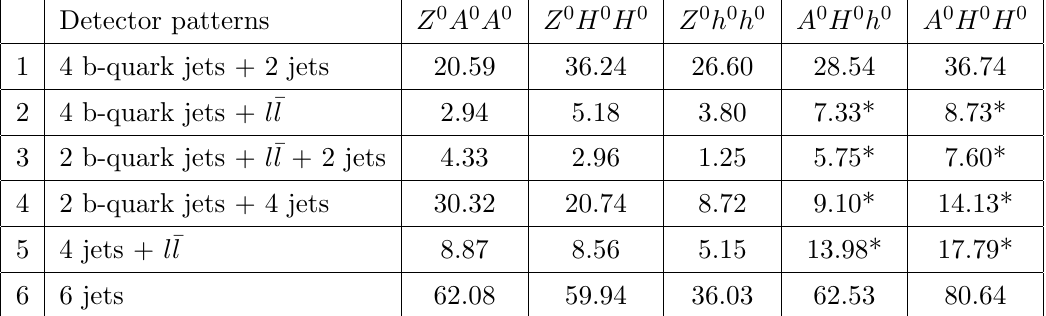
Table 3 . The percentage of the events with di(cid:11)erent decay channels are given. Since there is no Z-boson in the last two processes, the stared numbers refer to (cid:28) (cid:22) (cid:28) decay channel in l (cid:22) l .